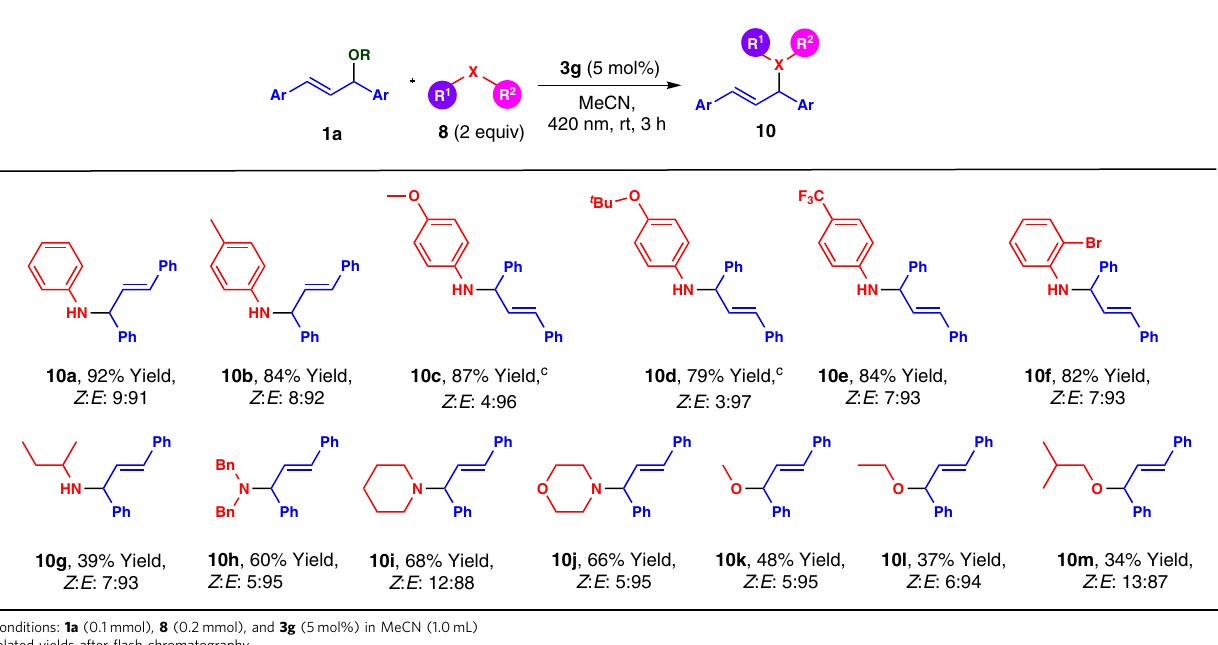
Table 5 Scope of the allylation reaction with amines and alcohols for the synthesis of E -isomers under photocatalyst 3g